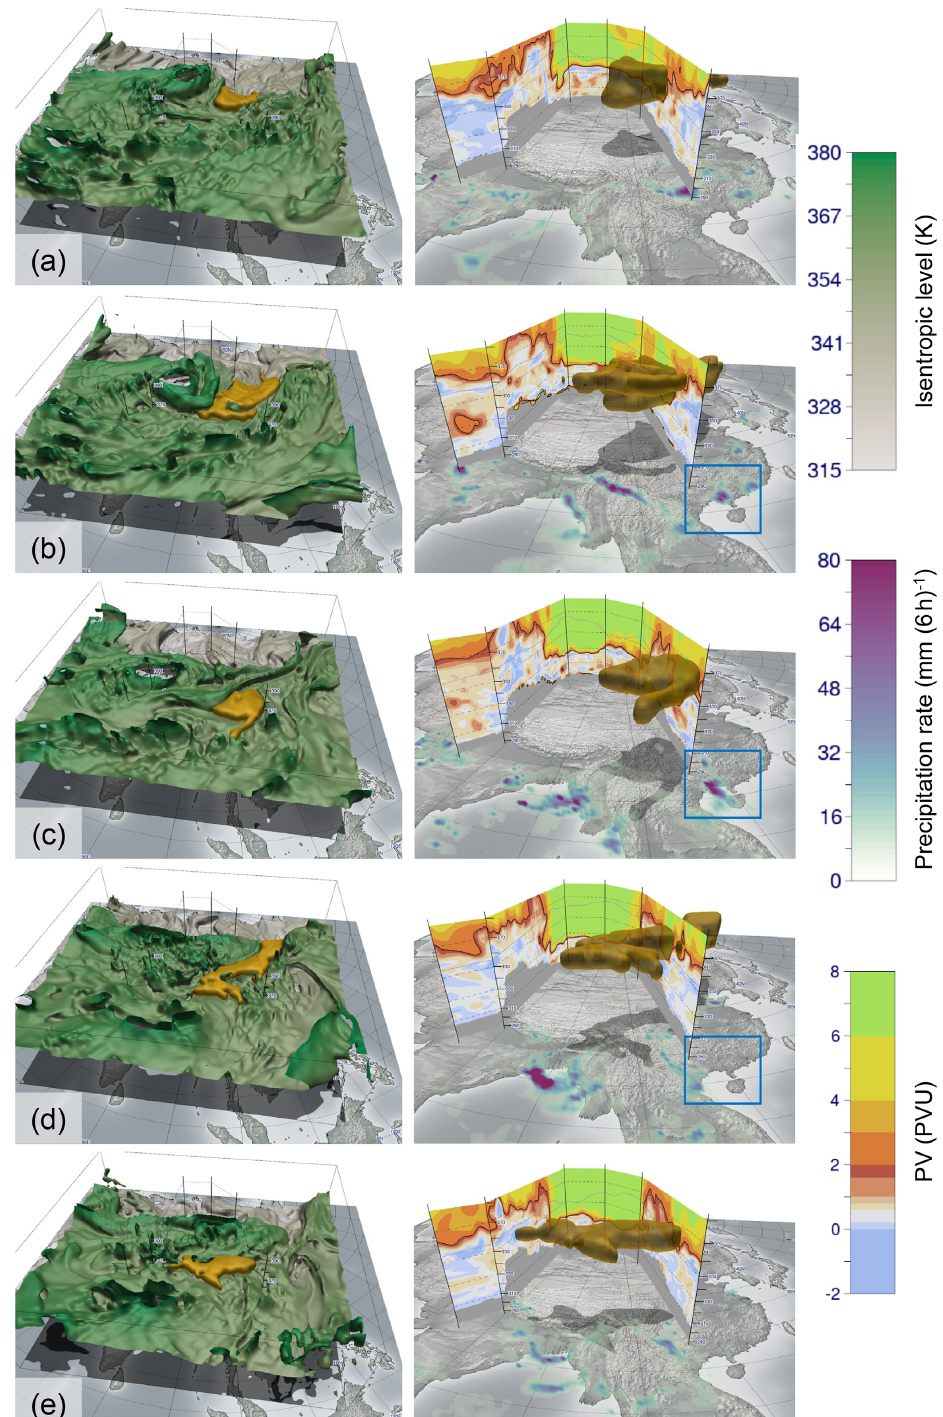
Figure 13. The synoptic–dynamic development associated with the event. Here, five time steps are visualized: (a) 22 July, 12:00 UTC; the dynamical tropopause shaded by isentropic height and the identified anomaly of interest are shown. On the right, the cross-section as displayed in Fig. 12c is shown. The blue box in (b–d) emphasizes the torrential rainfall triggering the flood. An animation with an extended time frame is provided in Fischer et al.